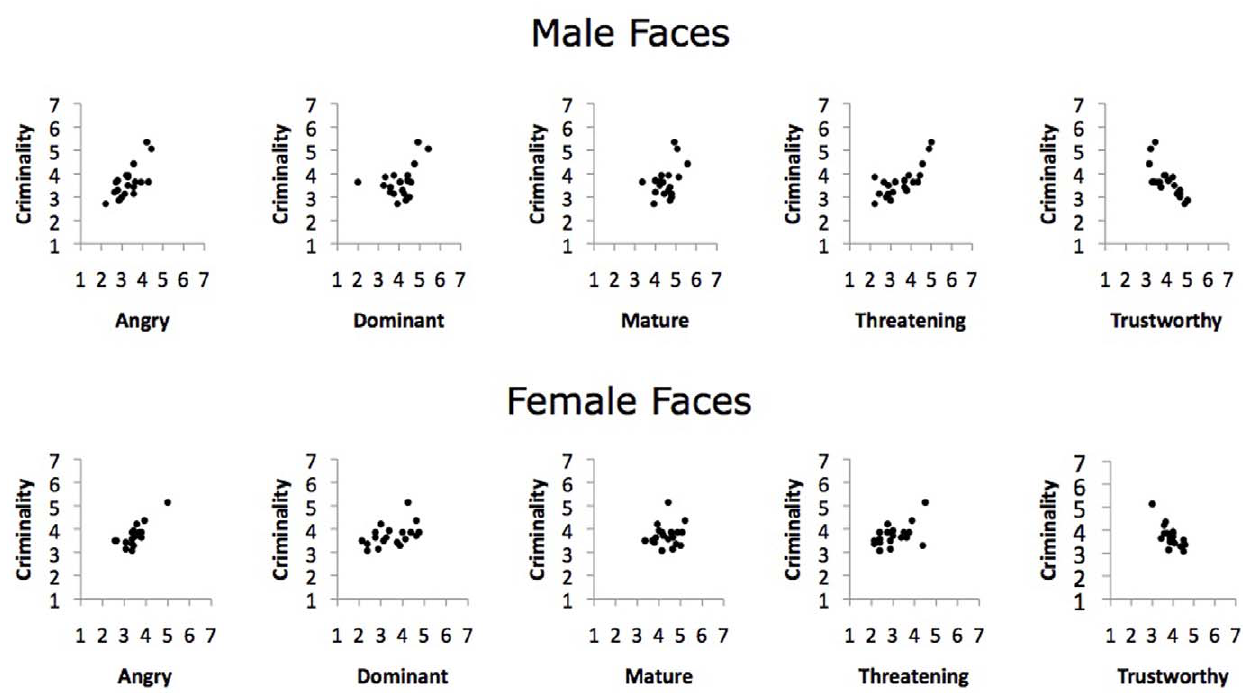
Figure 2. Scatterplots illustrating the bivariate relationship between criminality with the other attributes measured for the controlled photos by face gender.